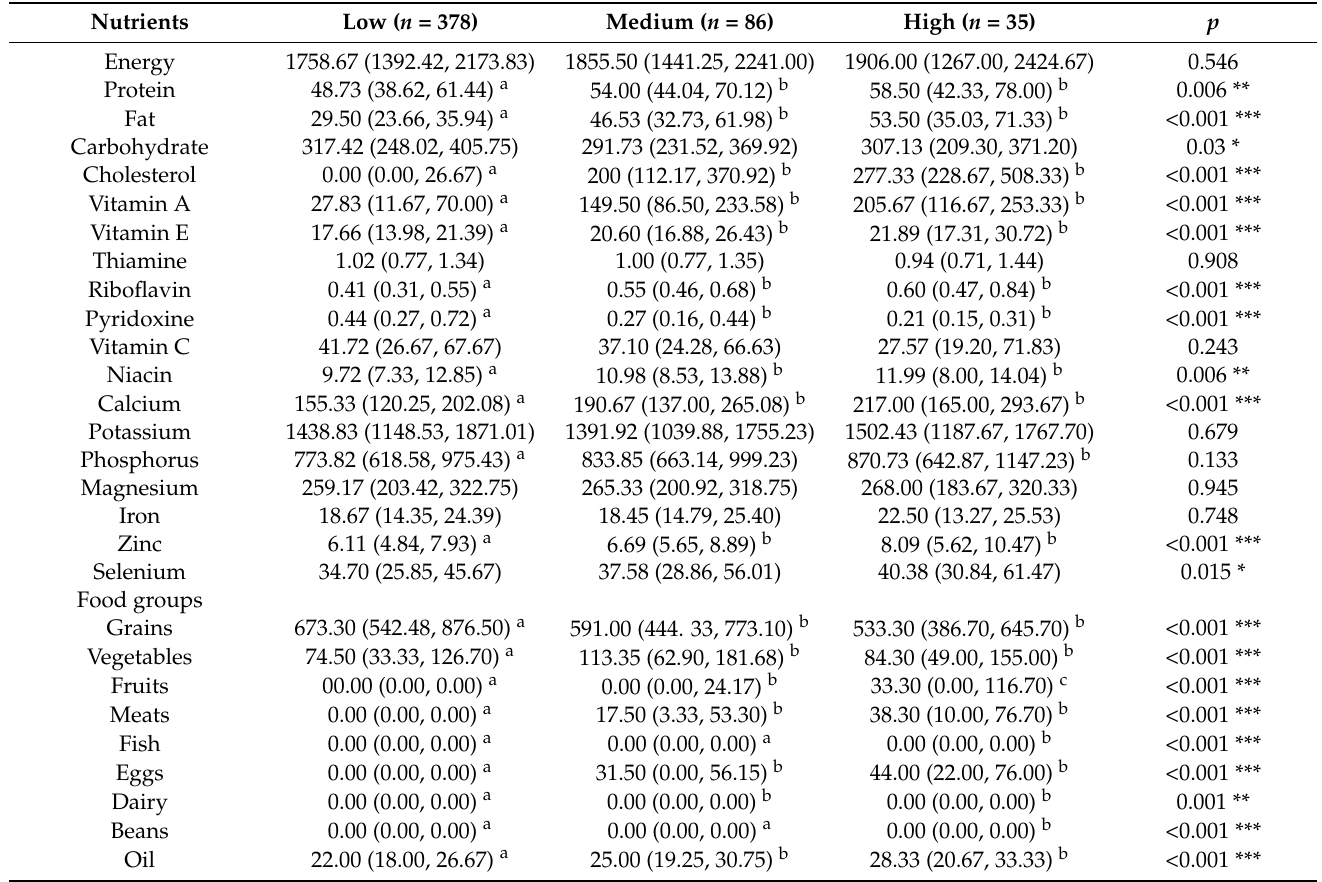
Table 3. Intakes of energy, nutrients and food groups based on dietary diversity score groups ( N = 499).